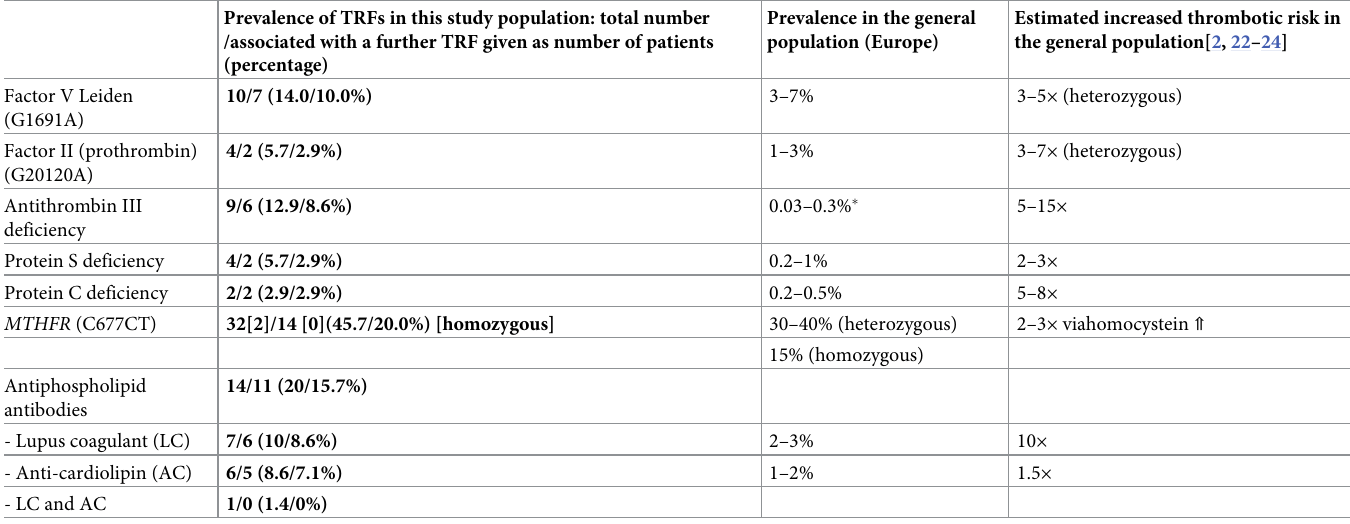
Table 2. Thrombophilic risk factors (TRFs) examined in this study. Prevalence of TRFs in this study population: total number /associated with a further TRF given as number of patients